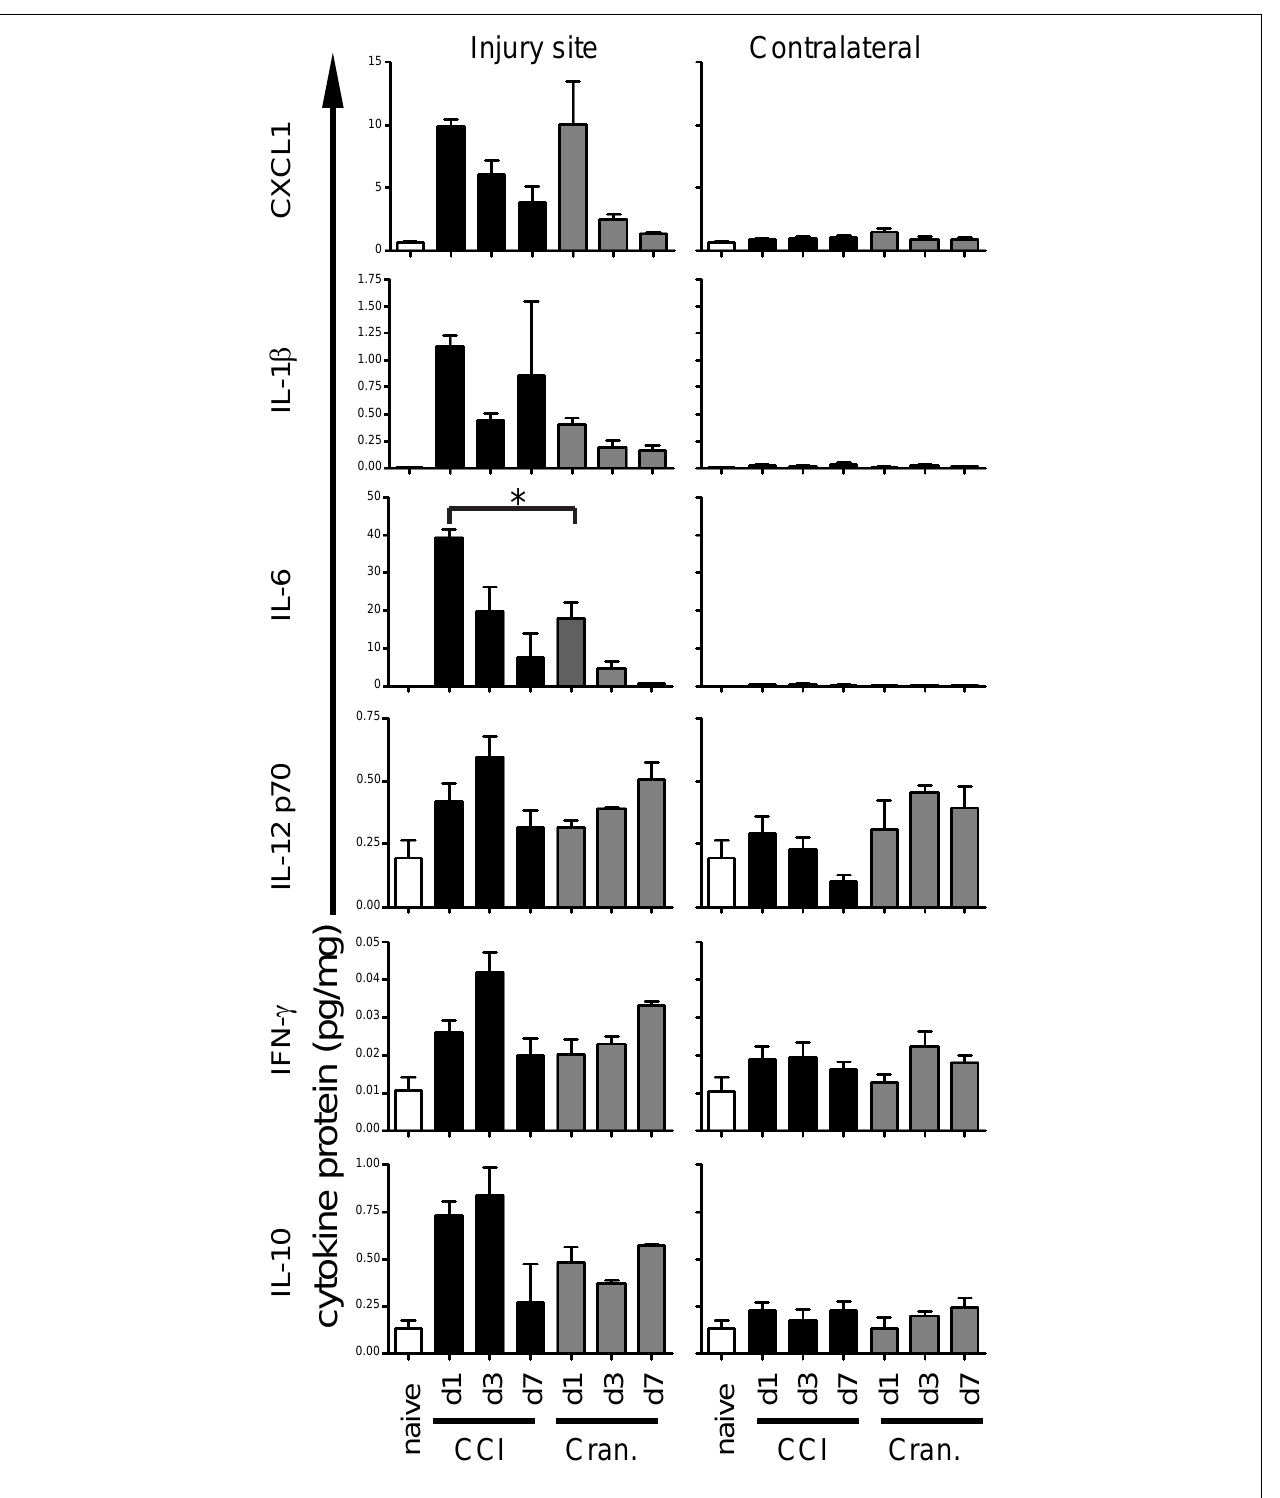
electrochemiluminescent immunoassay.Three mice from each experimental group (naïve, craniotomy, and CCI) were used for this analysis. Error bars are SEM. Statistically significant differences between groups are indicated in Table 3 . Additionally, the single finding of a statistically significant difference between CCI and craniotomy on equivalent days is indicated by an asterisk